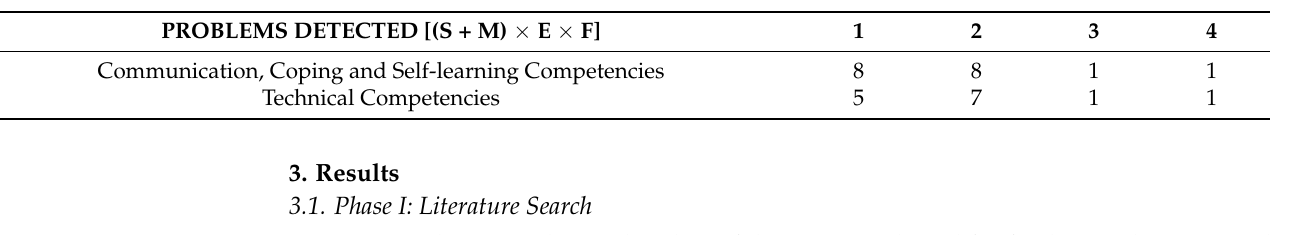
Table 3. Prioritization of educational actions according to the needs detected. Hanlon